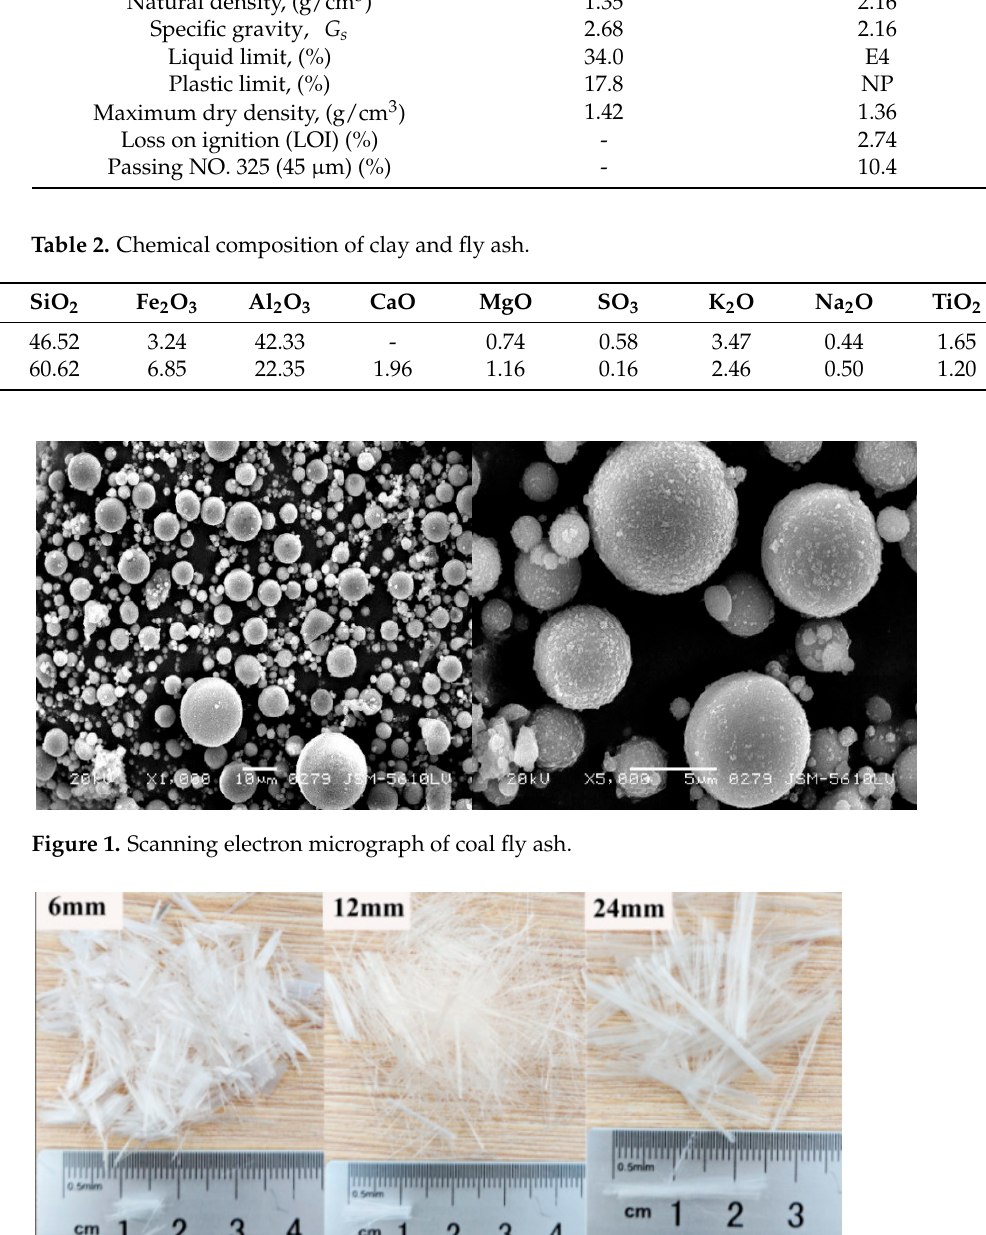
Table 1. Physical properties of clay and fly ash.